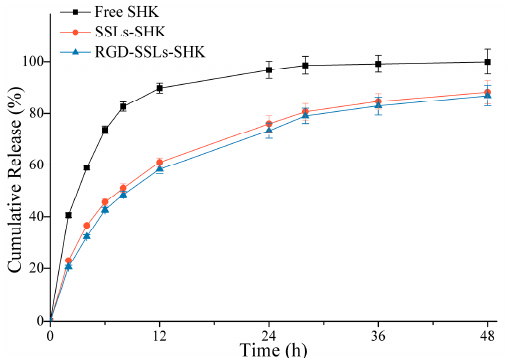
Figure 3. In vitro cumulative release of SSLs-SHK, RGD-SSLs-SHK, and free SHK at pH 7.4 for 48 h.